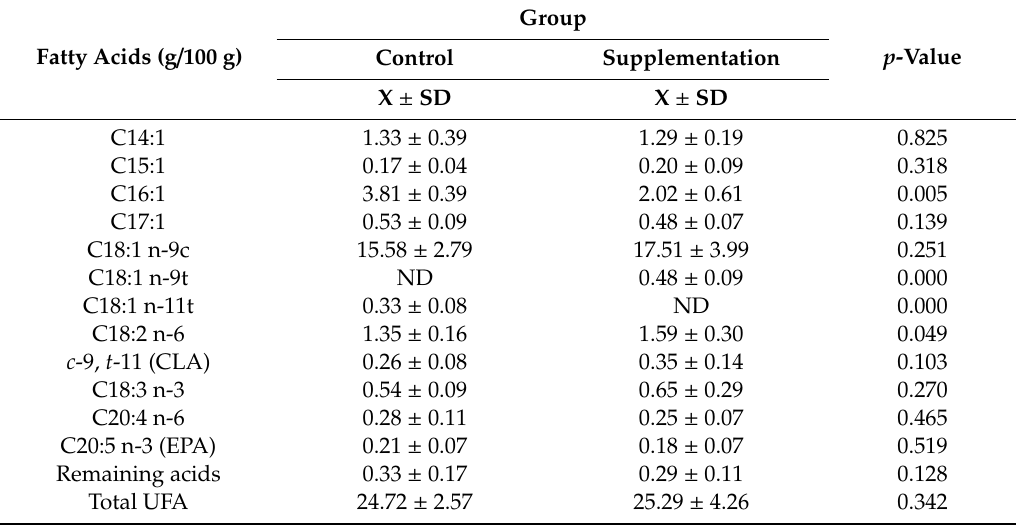
Table 4. Unsaturated fatty acids (UFA) profile (mean ± SD) in colostrum from Charolaise cows assigned to control (n = 10) and supplementation (n = 10; diet supplemented with soy lecithin) group. Fatty Acids (g / 100 g)